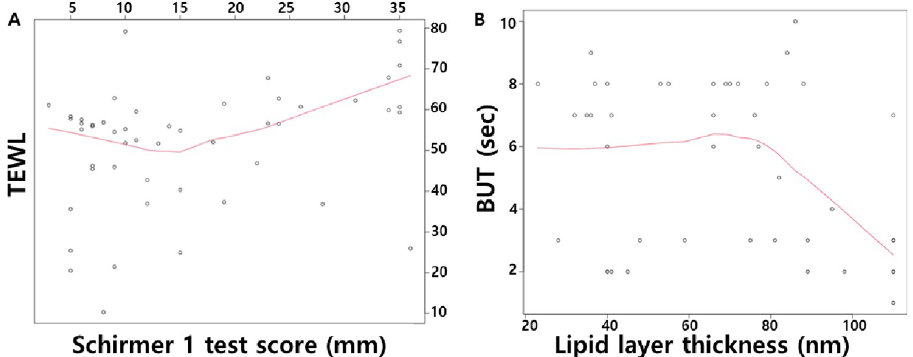
Fig 2. Correlation between TEWL and Schirmer 1 test scores (A), correlation between TBUT tear break-up time) and LLT (B) in all participants. (A) TEWL was correlated with Schirmer 1 test values ( p = 0.004). (B) TBUT was significantly correlated with LLT ( p = 0.004) and tended to decrease when LLT was abnormally thick. The red line represents the logically estimated scatterplot smoothing curve. TEWL, transepidermal water loss; LLT, lipid layer thickness; TBUT, tear break-up